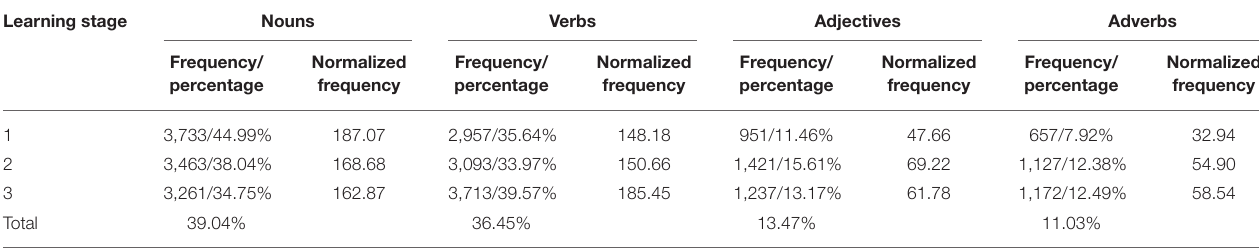
TABLE 6 | Distribution of lexical word classes across learning stages. Learning stage